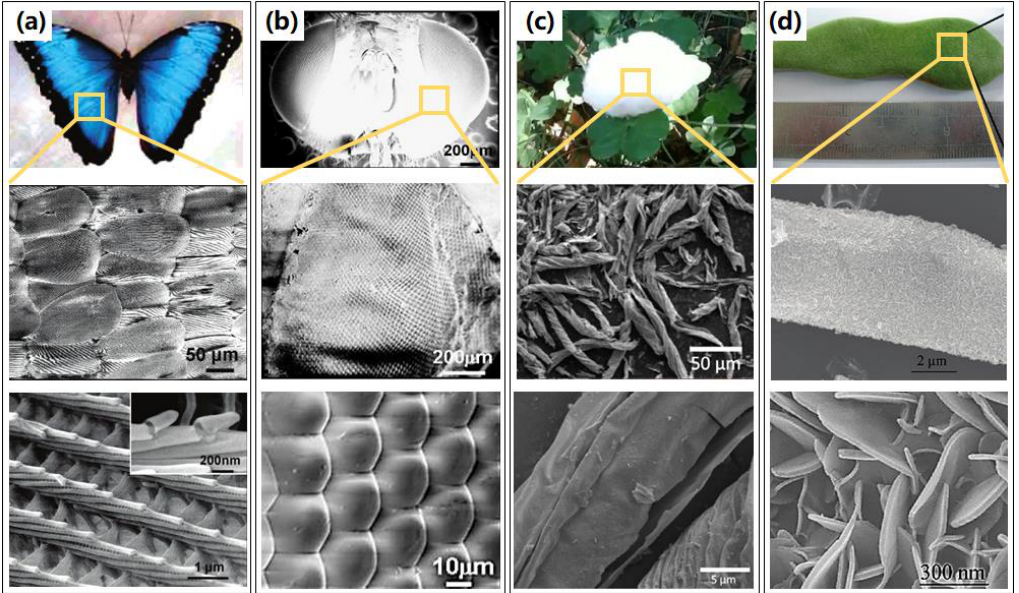
Figure 5. Attractive 3D nanostructures fabricated by ALA method through biological templates, with the photo image of veritable biological template, overall and enlarged SEM images in local area. ( a ) The biological templates of butterfly wings, with overall and enlarged SEM images of the alumina replicas of the butterfly wings. Reprinted with permission from Ref. [31], Copyright 2006